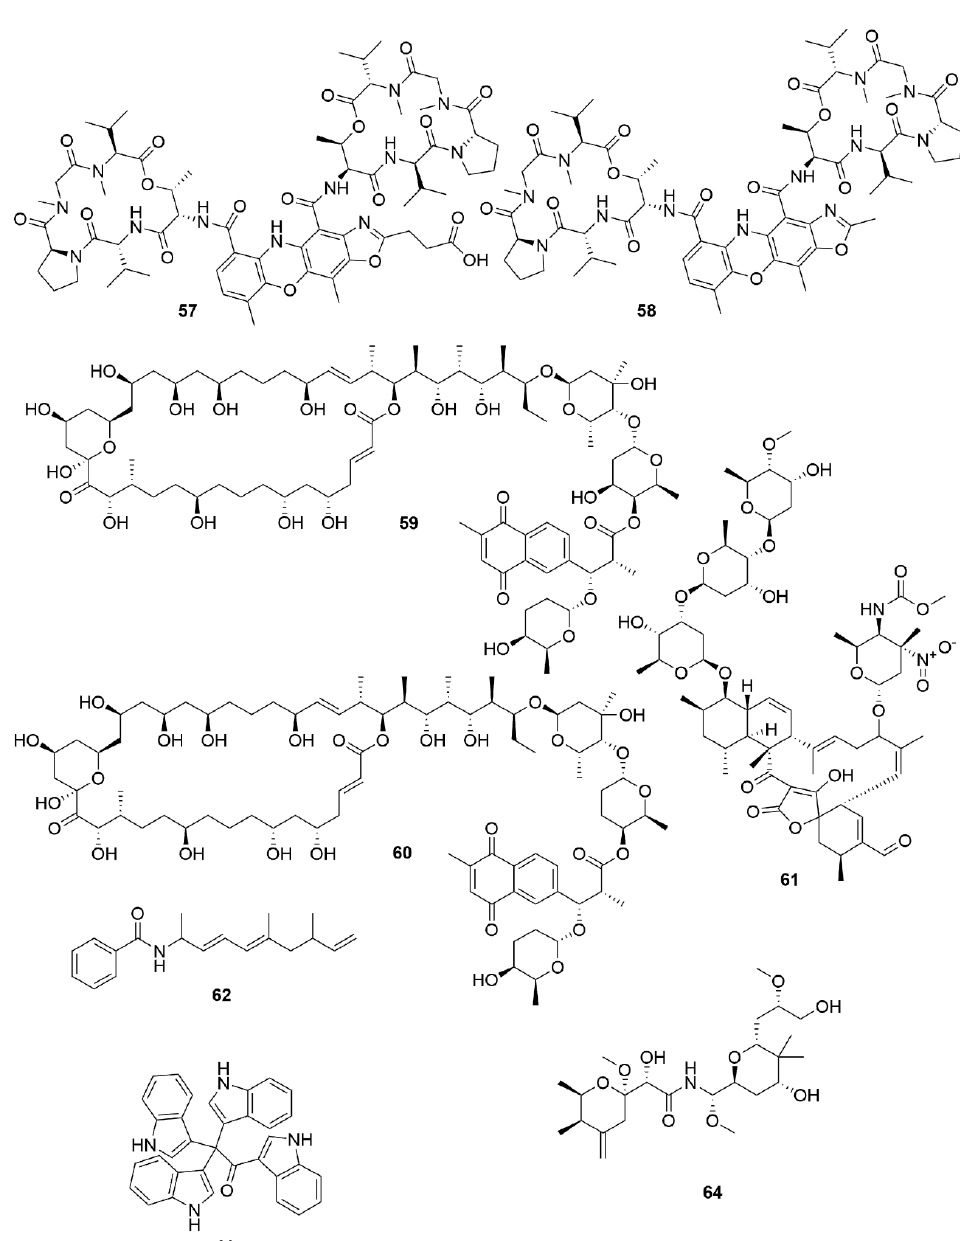
Figure 6. Examples of recently isolated cytotoxic natural products from marine bacteria. Neo-actinomycin A ( 57 ) and Neo-actinomycin B ( 58 ) are chromopeptides from Streptomyces sp. IMB094. PM100117 ( 59 ) and PM100118 ( 60 ) are macrolides isolated from S. caniferus GUA-06-05-006A. Lobophorin I ( 61 ), a spirotetronate isolated from Streptomyces sp. 1053U.I.1a.3b. Haliamide ( 62 ), a hybrid of a polyketide synthase from H. ochraceum SMP-2. Tetra(indol-3-yl)ethenone ( 63 ), an indole isolated from P. denitrificans BBCC725. O-Demethylpederin ( 64 ), a polyketide with a tetrahydropyran-core from Labrenzia sp. PHM005.